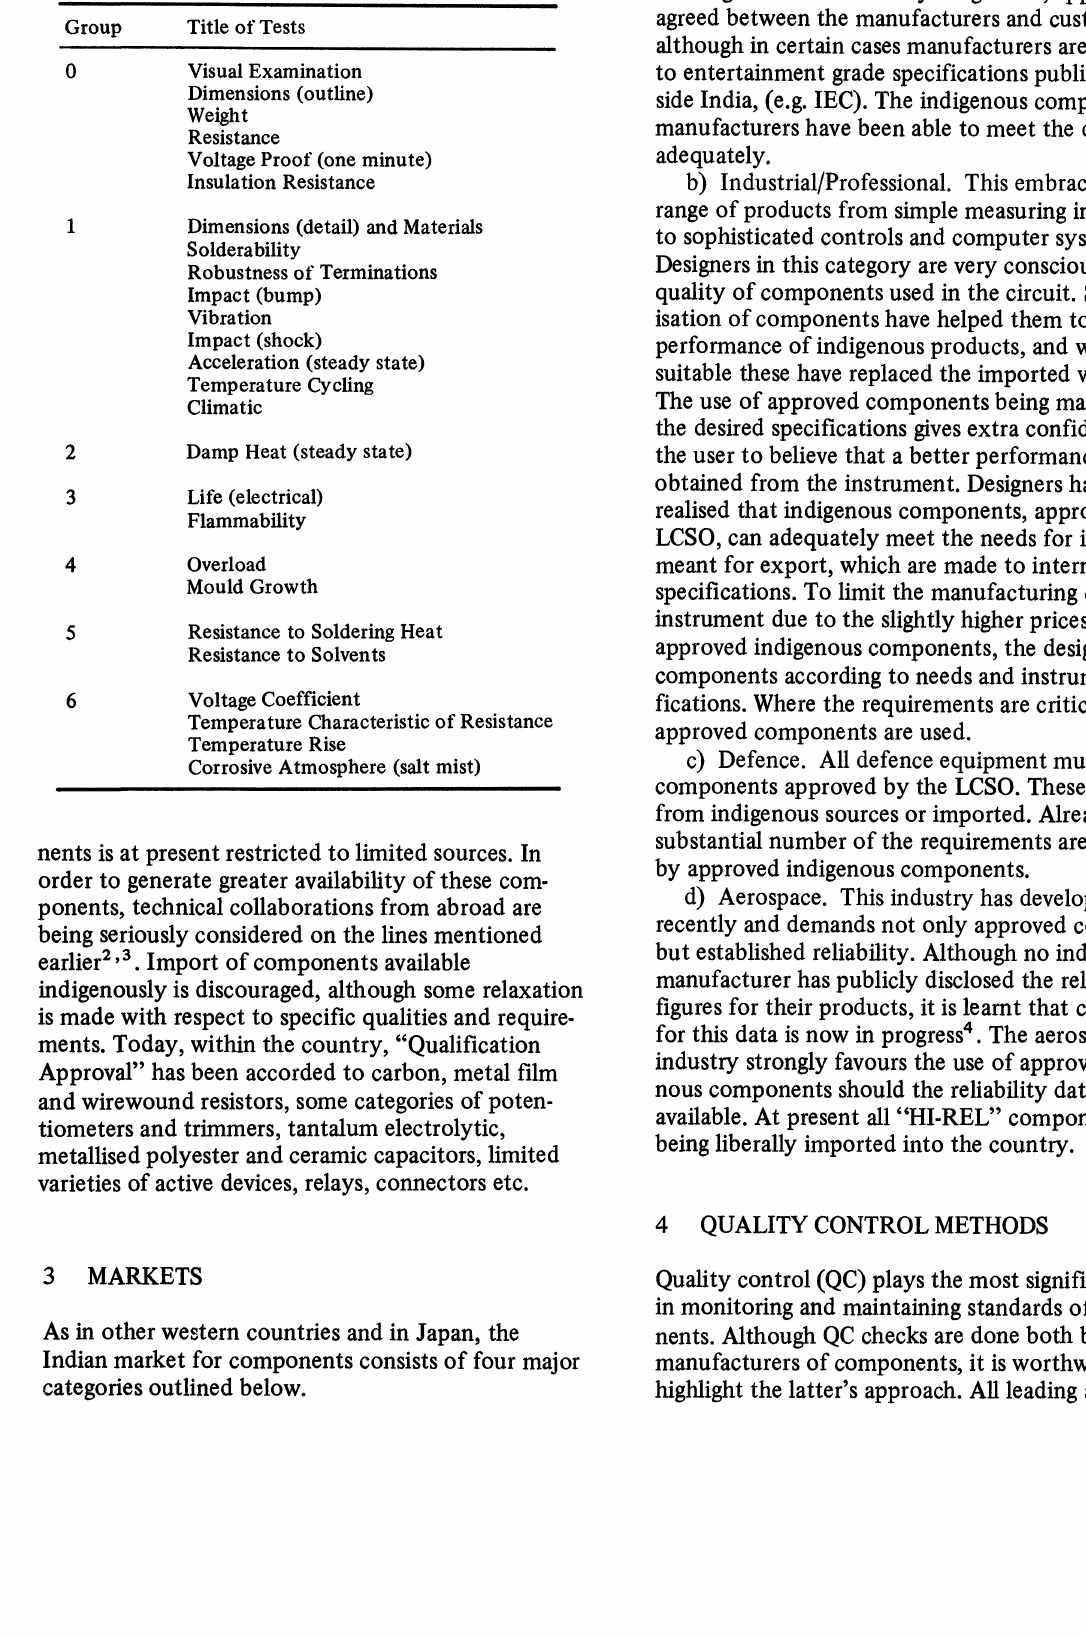
TABLE Qualification/Approval Tests for Fixed Resistors (as